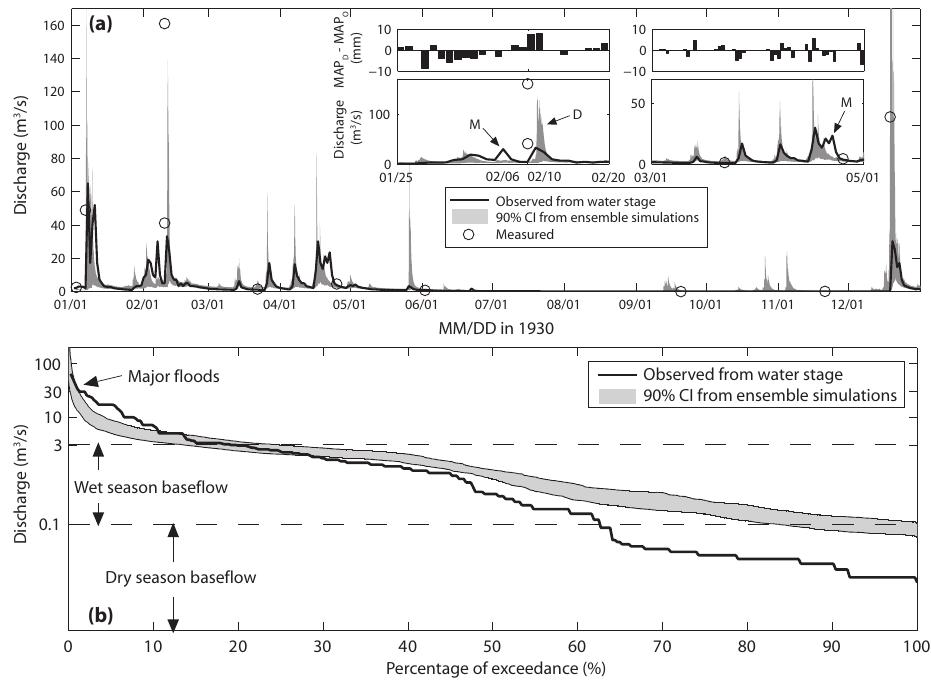
Fig. 9. Result of the tRIBS model calibration (year 1930). (a) Comparison between the observed discharge against the 90% confidence intervals (CIs) derived from the 50 ensemble simulations of the tRIBS model. In the insets, a zoom on two periods with significant flood events is reported to visualize the comparison better, along with the difference between the daily MAP D and MAP O (see text for the definition). The circles represent the discharge values measured by the Italian Hydrologic Survey to update the rating curve. (b) Comparison between the observed flow duration curve and the 90% confidence intervals derived from the 50 ensemble simulations.